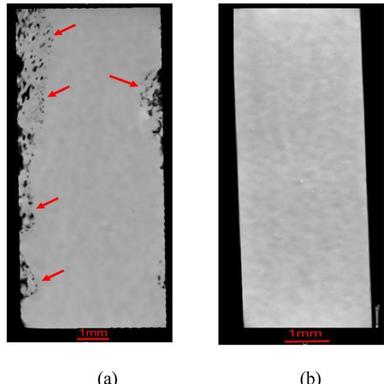
(a) X-CT image of ECM sample. All pores in ECM samples are present in the top and bottom surface only and contain a total of 4.30 volume % voids. (b) X-CT image of IM sample. IM samples contain a total of 0.007 volume % voids.